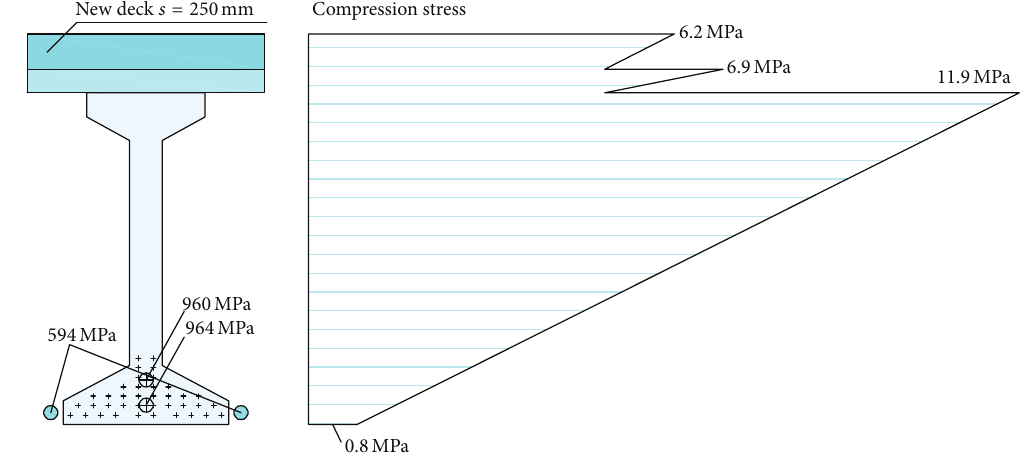
Figure 9: Stress diagram at midspan cross-section of